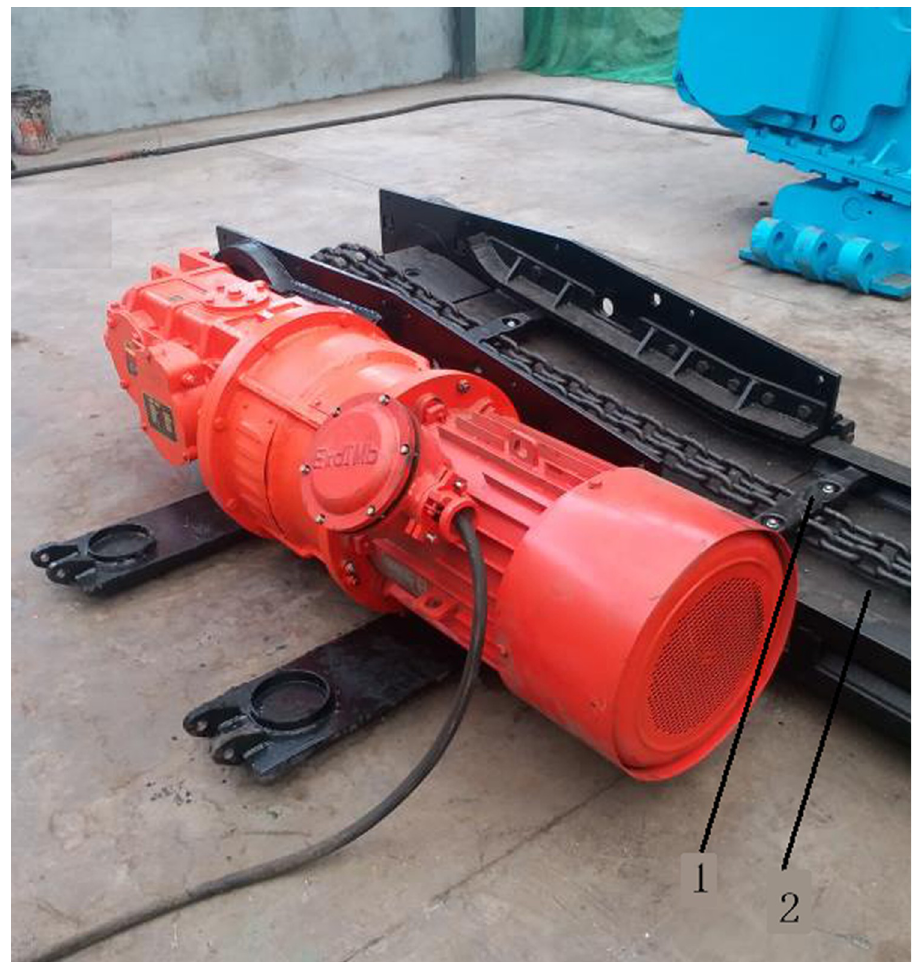
Fig 4. Scraper conveyor in the validation test: 1-scraper, 2-middle